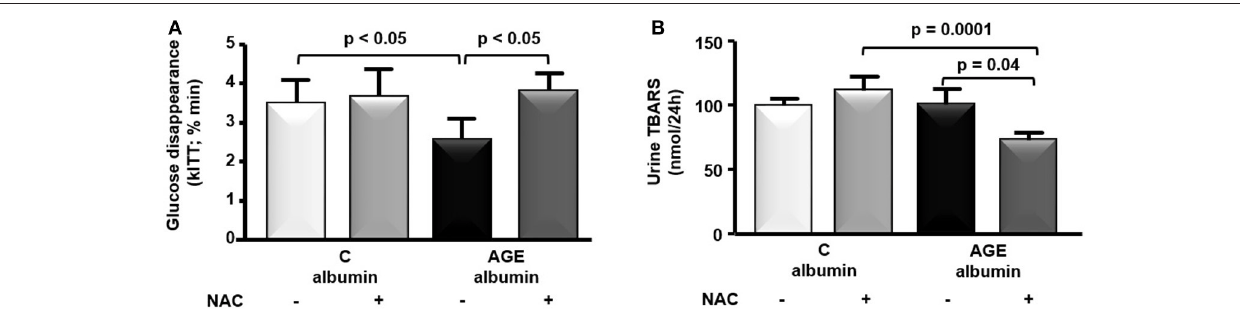
FIGURE 2 | Insulin tolerance test and urine thiobarbituric acid reactive substances (TBARS). (A) At the end of the protocol, insulin tolerance test (ITT) was performed in animals treated with C-albumin ( n = 3), C-albumin + NAC ( n = 4), AGE- albumin ( n = 4), and AGE-albumin + NAC ( n = 4). Blood samples were collected from the tail vein 0, 4, 8, 12, and 16 min after an intravenous injection (penis vein) of regular insulin (100 UI/mL/kg) and glucose disappearance constant (kITT; % min) was determined. (B) TBARS (nmol/24 h), markers of lipid peroxidation, were determined in 24-h urine samples at the end of the protocol in C ( n = 6), C + NAC ( n = 5), AGE ( n = 6), and AGE + NAC ( n = 5) groups. The optical density was read at 534 nm. Results (mean ± SEM) were compared by One-way ANOVA with Newman-Keuls